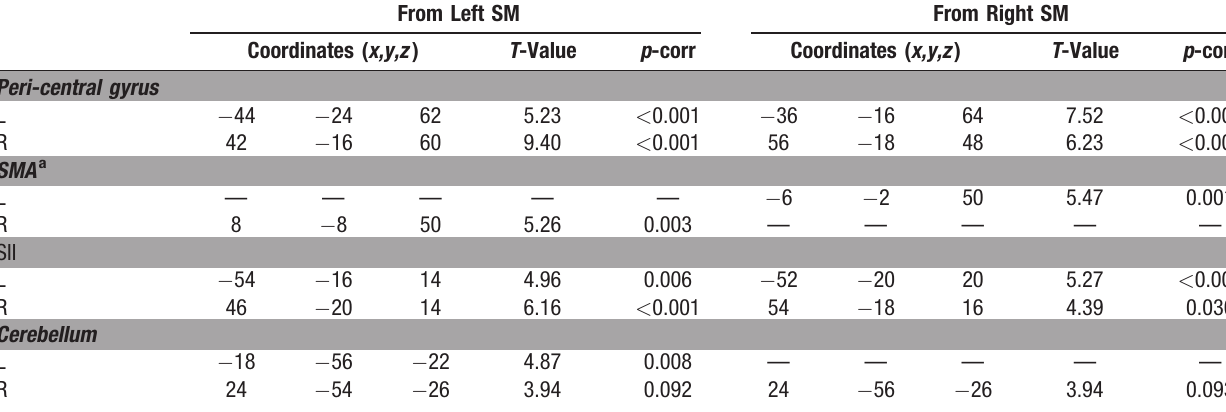
Table 2. Decreased coupling during passive movement versus